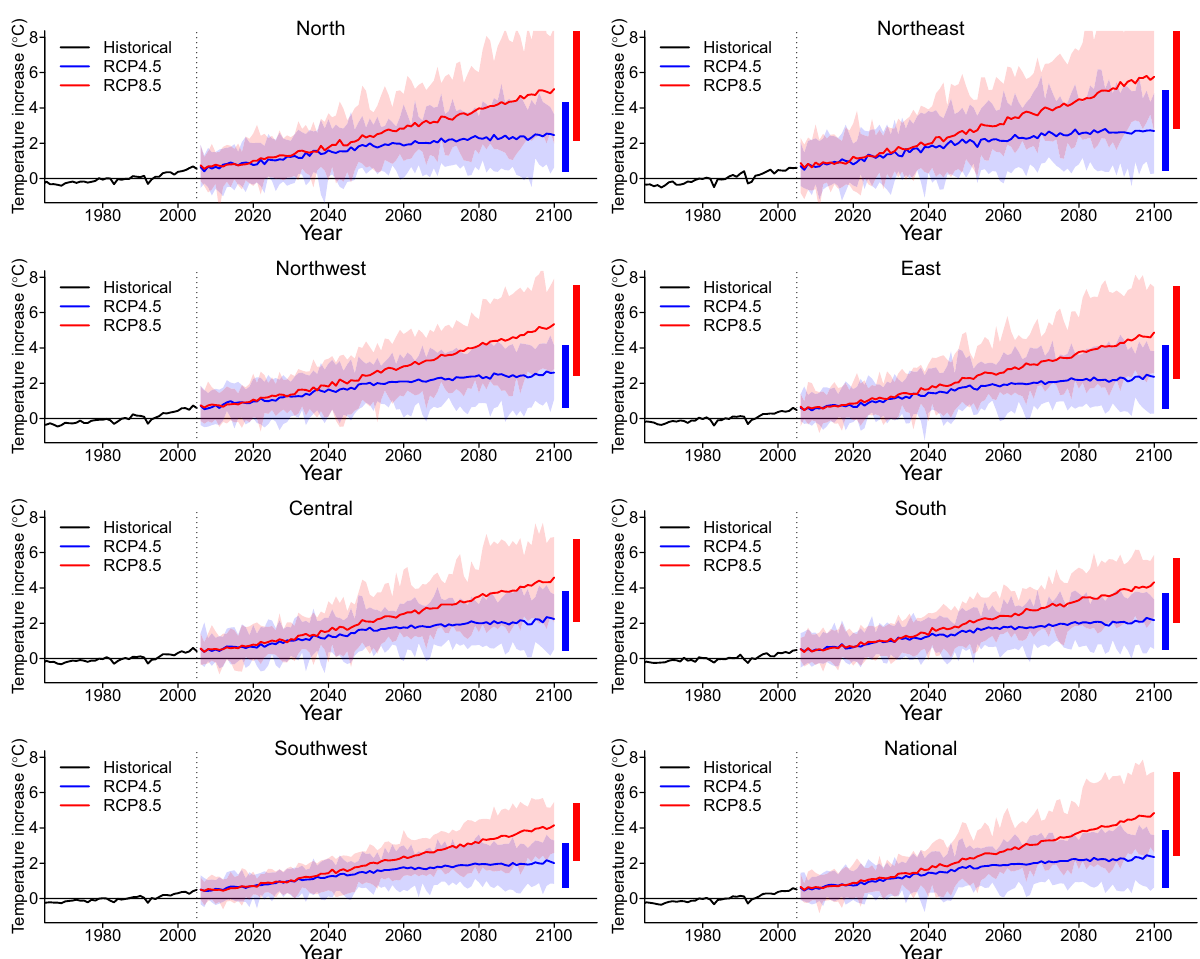
Fig. 2 Temporal trends in projected temperature in China. RCP4.5 and RCP8.5 represent the low and high emission scenarios, respectively. Solid lines denote the mean annual temperature estimated across the 28 general circulation models. The shaded areas denote the temperature range for each year. The two vertical bars on the right show the average annual minimum and maximum for each projected temperature series. Source data are provided as Supplementary Data